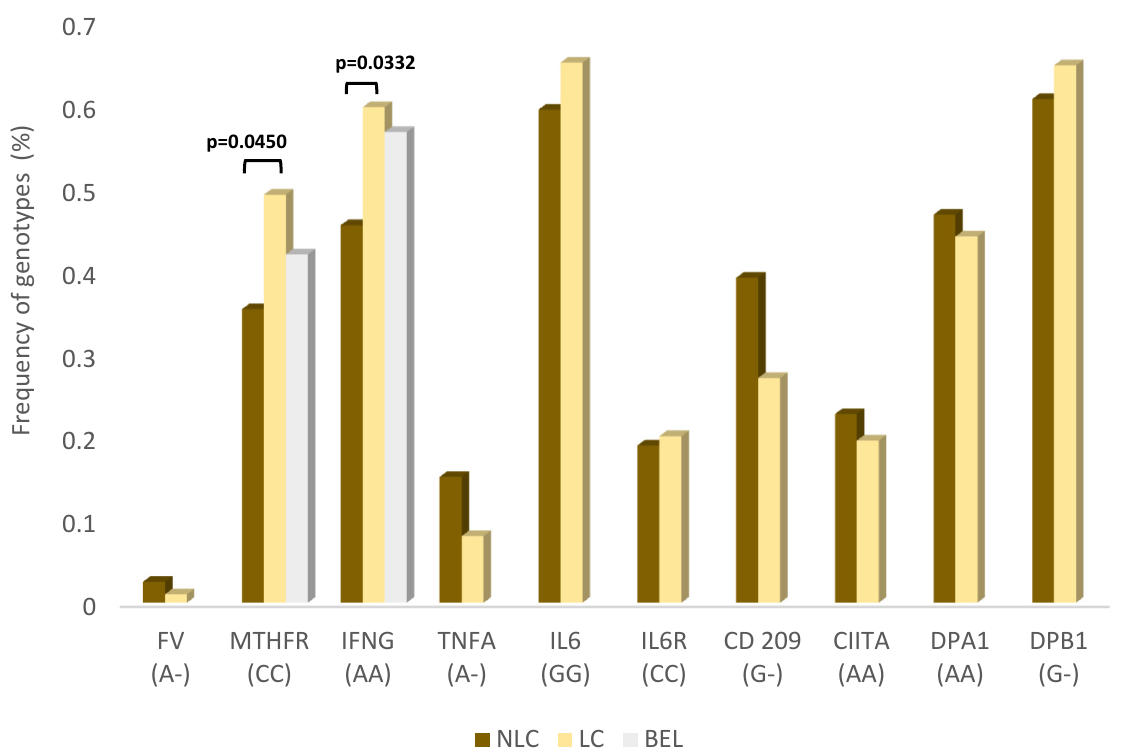
Figure 1. Frequency (%) of single nucleotide polymorphism (SNP) genotypes in patients with non- long COVID (NLC; N=79), long COVID (LC; N=199) and in the general population of Belém (Bel; obtained from published papers prior to the pandemics, thus representing the frequencies in general population of Belém without any sampling biases induced by the pandemics). NLC are patients who have not reported symptoms or sequelae after COVID-19. LC are patients with reported symptoms for over 3 months. The SNPs are discriminated information about genotypes and their respective effects in gene product expression are given. For LC and NLC subsamples composed of asymptomatic or mild or patients. Fisher’s exact test.